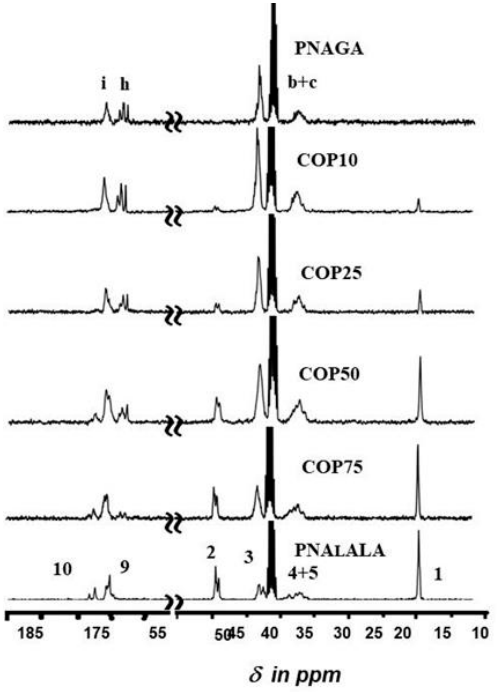
Figure 6. The 13 C-NMR spectra ( bottom ) of homopolymers and copolymers in DMSO at 100 °C. Assignments of the various carbon atom resonances are based on the formula in Figure 4 ( right ).